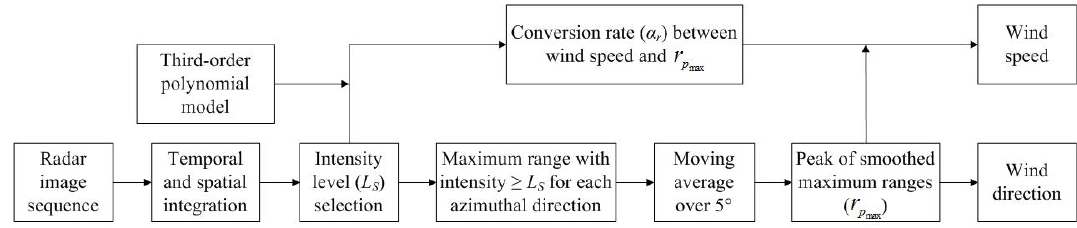
Figure 5. Basic steps of the original Intensity Level Selection (ILS)-based method for wind parameter